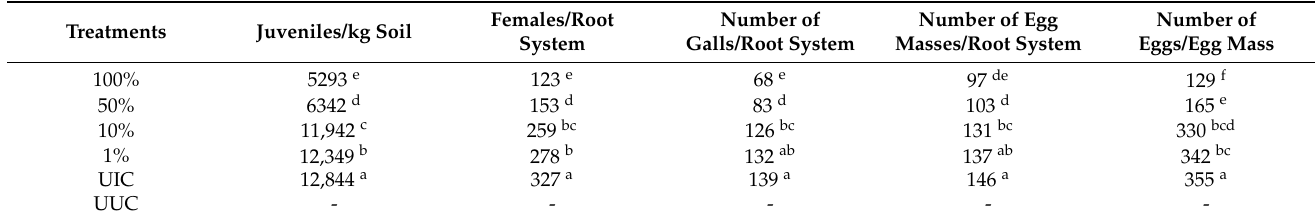
Table 6. Effect of G. lucidum CFs on the multiplication of M. incognita infesting eggplant.